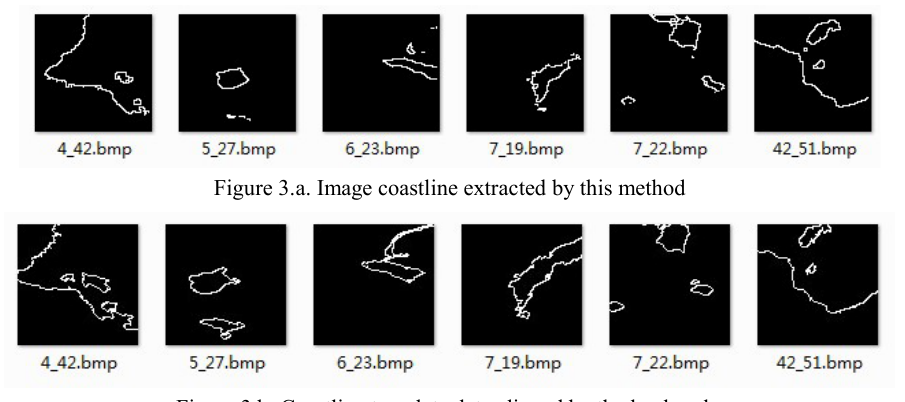
Figure 3.b. Coastline template data clipped by the